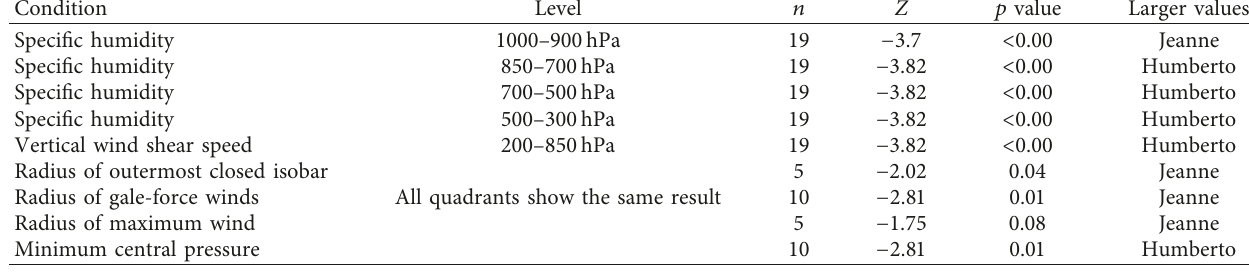
Table 1: Results of Wilcoxon rank sum tests for atmospheric conditions and storm size for data aligned according to time of landfall.